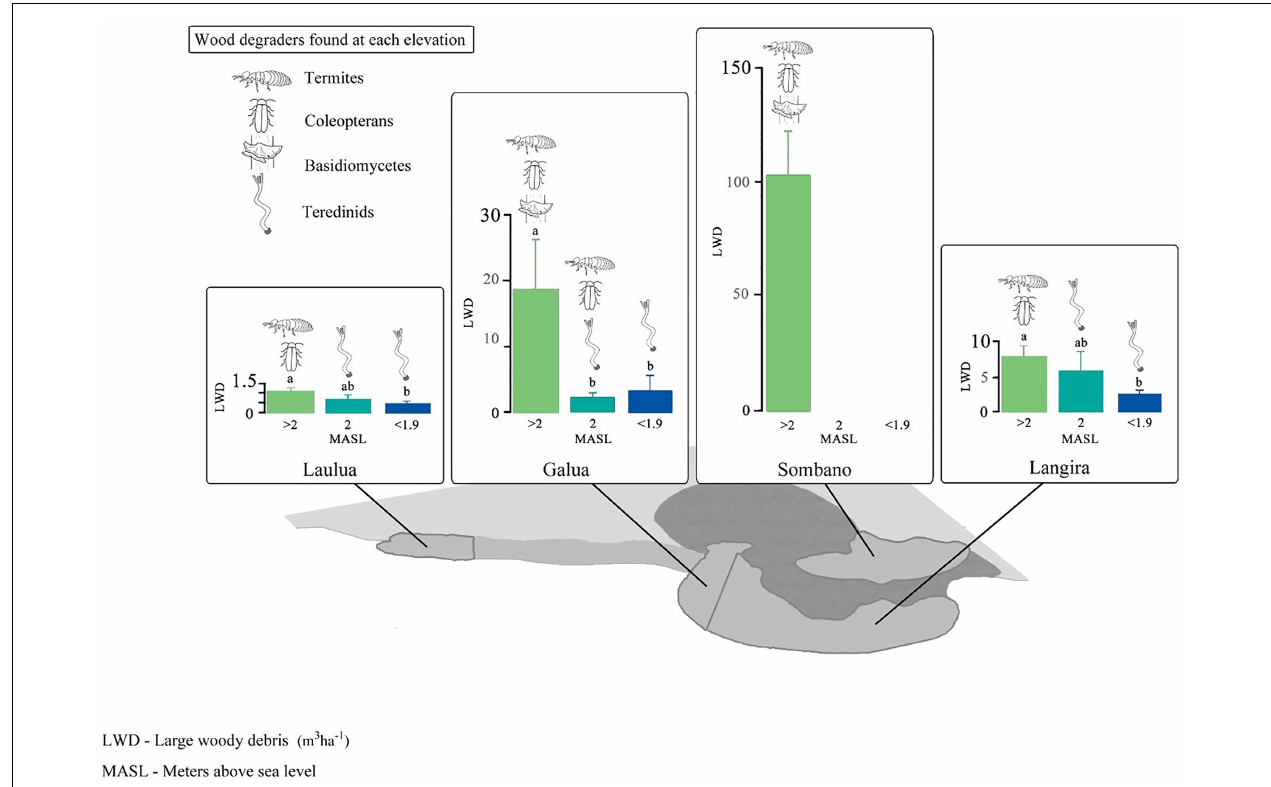
FIGURE 4 | Guilds of wood-degrading organisms across four mangrove forests in Kaledupa Island, Indonesia. Letters above the bars represent differences according to post hoc Tukey’s pairwise tests. Note, the scales on the y -axes differ.